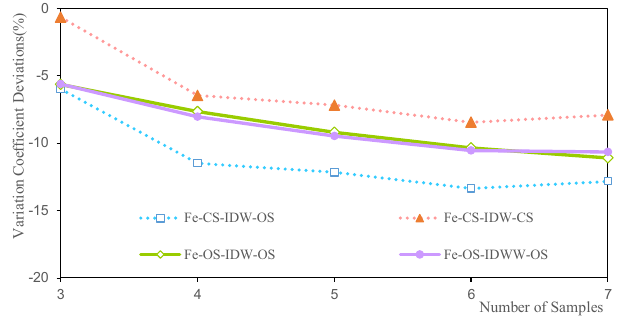
Figure 20. Deviation of the variation coefficient of the Fe